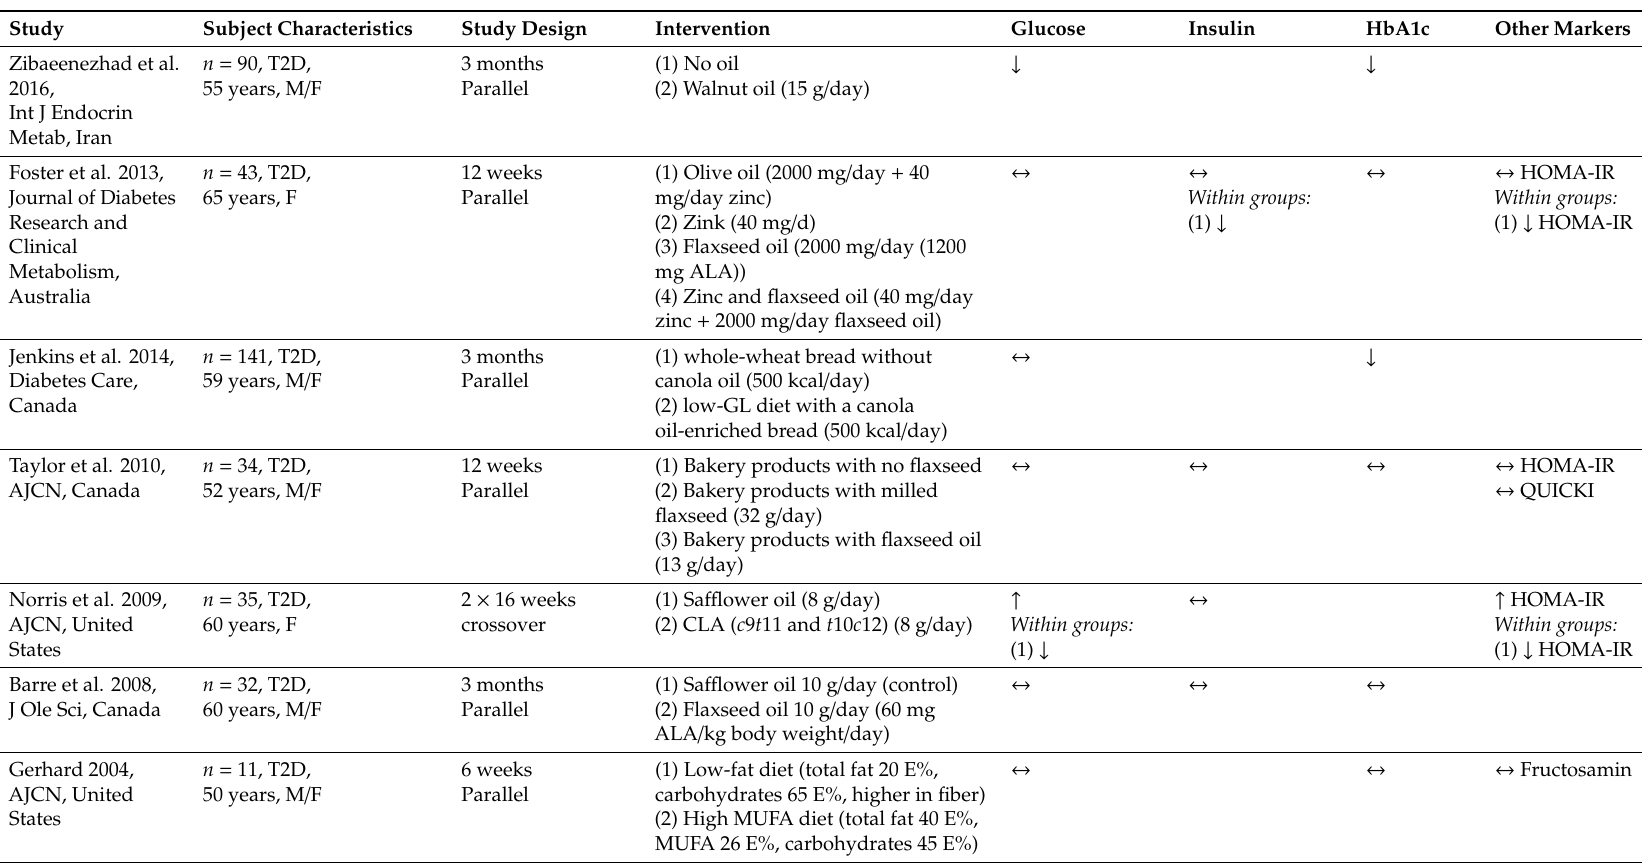
Table 2. E ff ects of vegetable oils on glycemic regulation in type 2 diabetes in randomized controlled trials. Significant results are indicated by an up / down